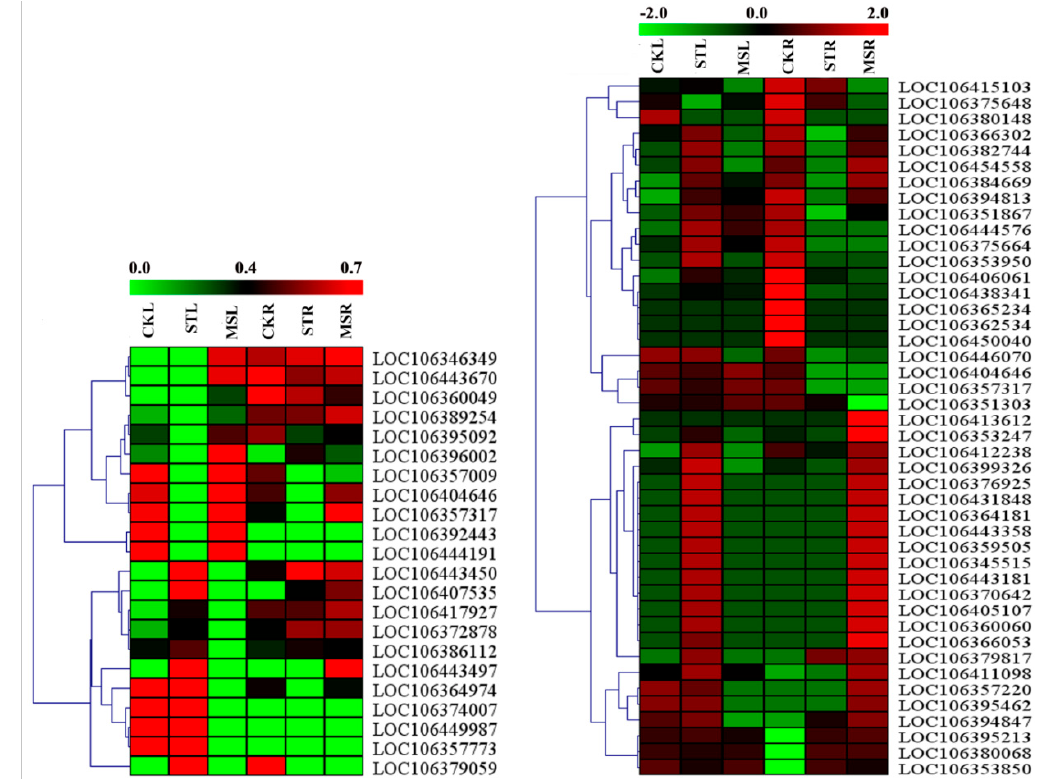
Figure 6. Expression modes of melatonin-specific transcription factor (TF) genes in the leaves and roots. Left : in the leaves. Right : in the roots. A redder color indicates more transcript accumulation, and greener indicates less. The codes of regulated genes at the right of filled blanks and the detailed explanations of these genes could be found in Table S3.